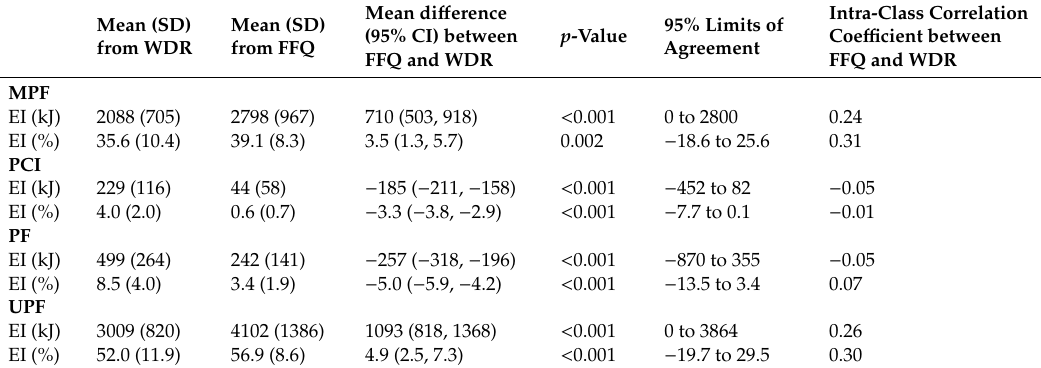
Figure 2. Bland–Altman plots for % energy intake between the FFQ and WDR: ( a ) Minimally Processed Foods (MPF), ( b ) Processed Culinary Ingredients (PCI), ( c ) Processed Foods (PF), ( d ) Ultra Processed Foods (UPF). Dashed lines represent 95% limits of agreement. Table 1. Difference and intra-class correlations between daily energy intake estimates from processed food categories between FFQ and 3 day WDR ( n = 100).